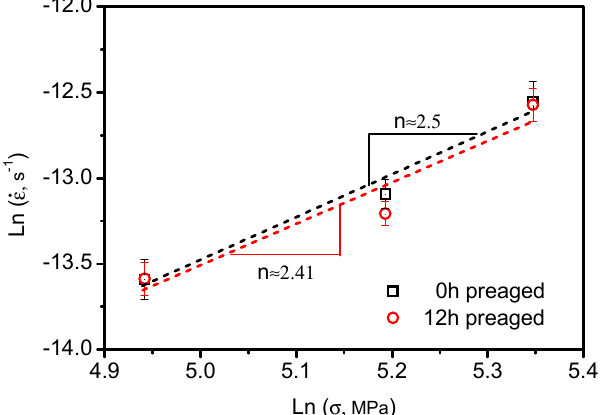
Figure 7. Relationship between ln𝜎 and ln𝜀(cid:4662) (cid:3046)(cid:3046) of the 0 h- and 12 h-preaged AA2524.